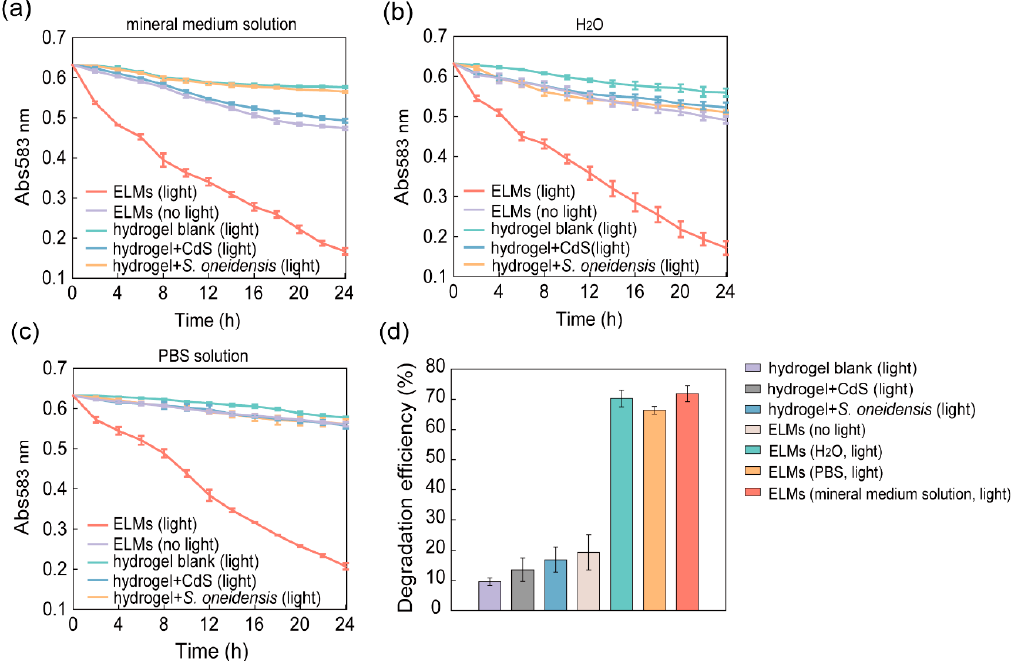
Figure 4. Photocatalytic degradation performance of engineered living materials (ELMs) with encapsulated nano-bacteria hybrids: ( a ) Change in concentration change of trypan blue after treatment with ELMs and controls in mineral medium solution. The ELMs were incubated in a mineral medium solution containing 20 mg/L trypan blue and irradiated by a tungsten filament lamp. Control groups included hydrogels (light), Shewanella oneidensis encapsulated in hydrogels (light), CdS encapsulated in hydrogels (light), and ELMs (no light). The photocatalytic degradation performance of ELMs was significantly improved compared to that of wild-type S. oneidensis cells encapsulated in hydrogels; ( b ) Change in concentration of trypan blue after treatment with ELMs and controls in water; ( c ) Change in concentration of trypan blue after treatment with ELMs and controls in PBS solution; ( d ) The concentration of trypan blue after 24 h of treatment was compared with the initial concentration to assess the trypan blue degradation efficiency. The concentration was determined by comparing it to a trypan blue calibration curve generated based on Abs 583 nm . The photocatalytic degradation efficiency of ELMs was not affected by the media (i.e., simulated wastewater, water, and PBS solution). The data are presented as mean ± s.d ( n = 2).